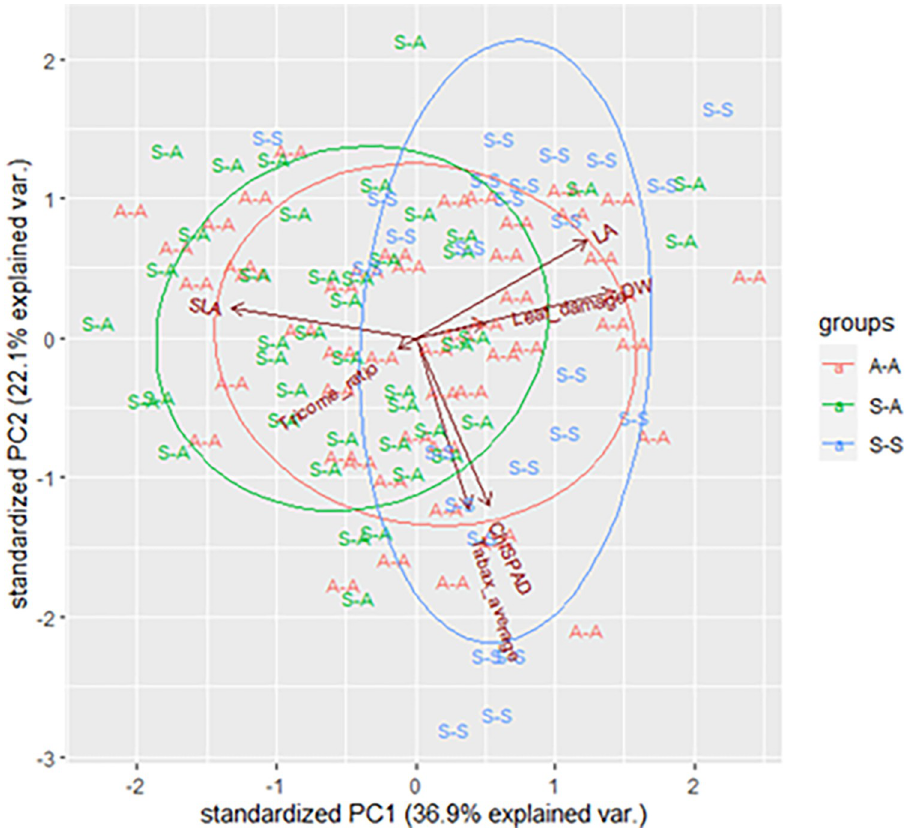
Fig 4. Principal component analysis (PCA) for the leaves of non-symptomatic plants (A-A), and for the non- symptomatic (S-A) and symptomatic leaves (S-S) of the symptomatic plants.